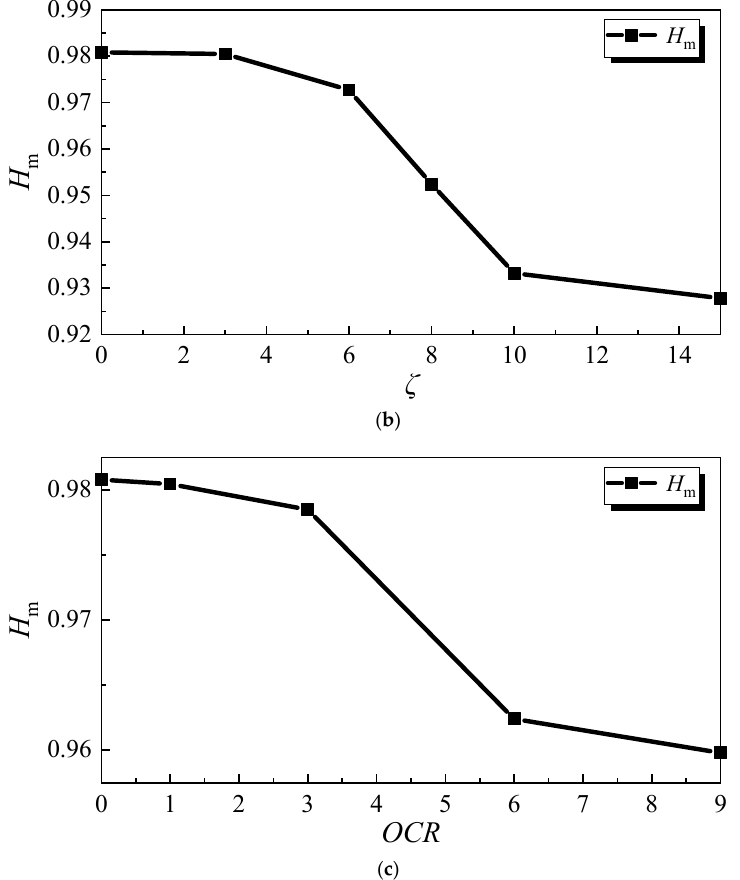
Figure 13. Probability entropy change diagram before and after loading under different test conditions: ( a ) SEM-A, ( b ) SEM-B, and ( c )